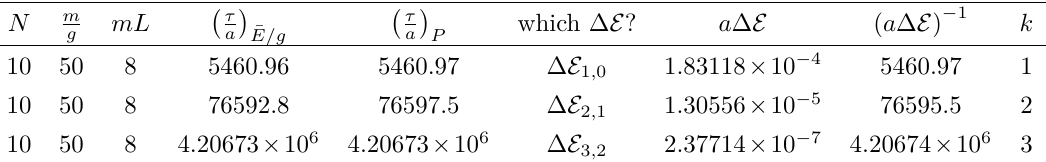
(cid:1) (cid:1) and (cid:0) τ ¯ E/g a a P , ∆ E and ∆ E are respectively the energy 1 , 0 2 , 1 3 , 2